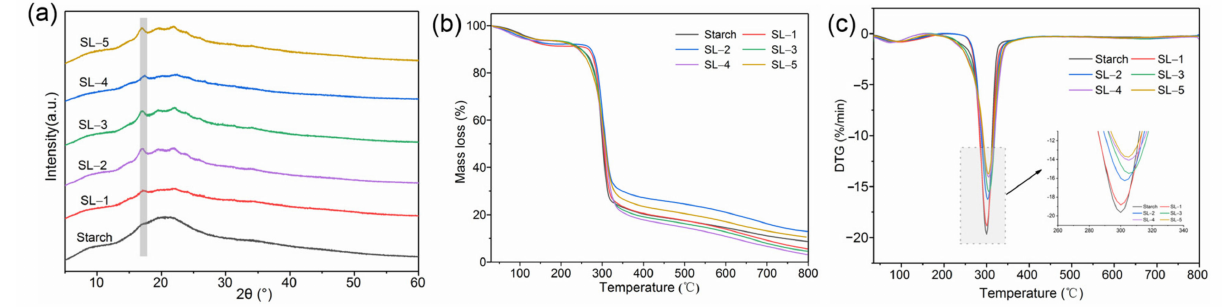
Figure 5. XRD pattern ( a ), TG ( b ) and DTG ( c ) curves of starch film and SL composite films containing 1% to 5%